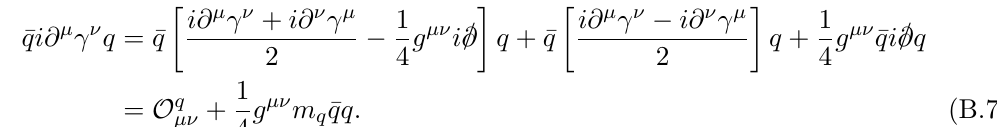
a G a(cid:22)(cid:23) , where a i = a; A . i a j G (cid:22)(cid:23)